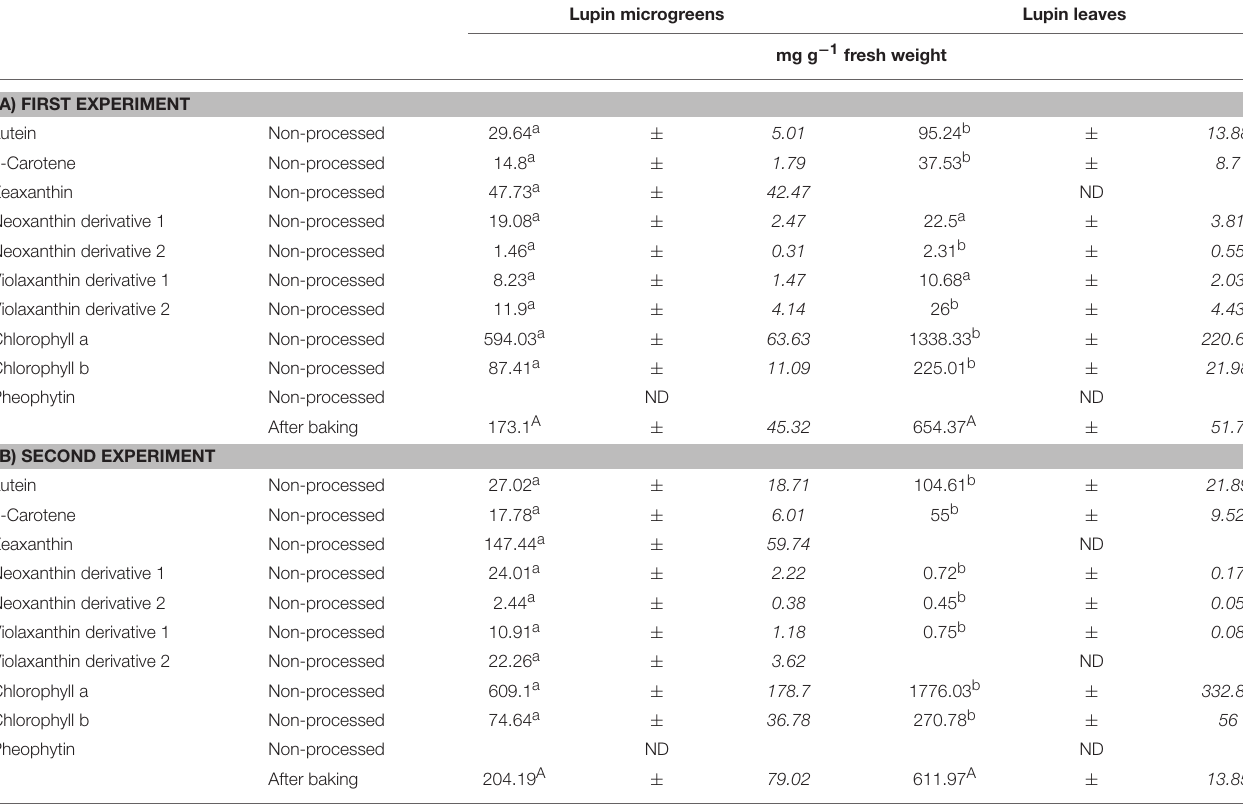
TABLE 4 | Average carotenoid and chlorophyll derivative concentration in Lupin microgreens (7 d) and lupin leaves (14 d): Non-processed and in the lupin-enriched bread. Lupin microgreens Lupin